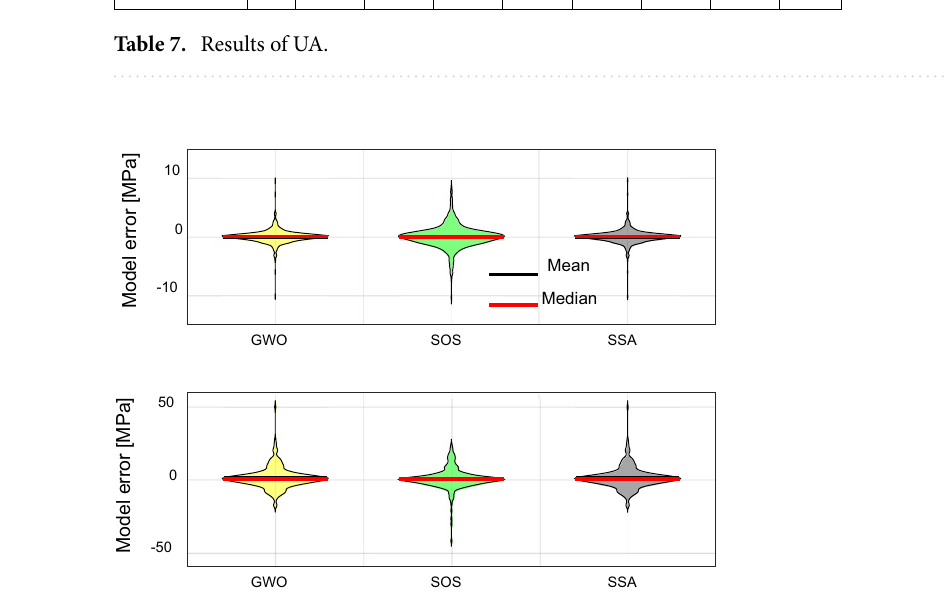
Figure 6. Violin plot for the proposed models in the training (upper) and testing (lower) stages.